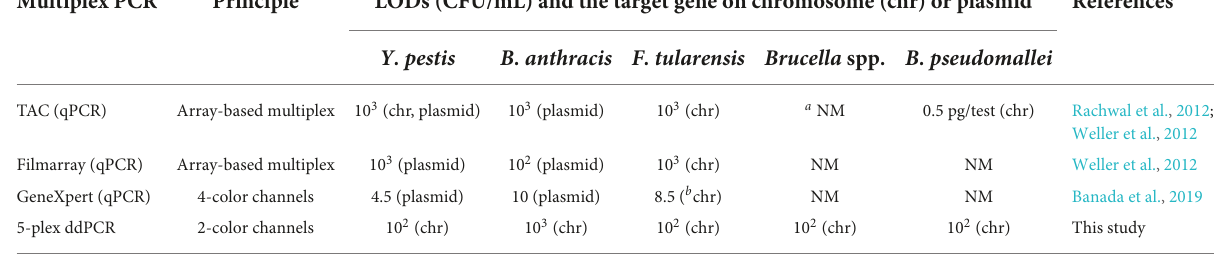
TABLE 4 Comparisons between reported multiplex real-time PCR and the 5-plex droplet digital PCR assay for the five selected